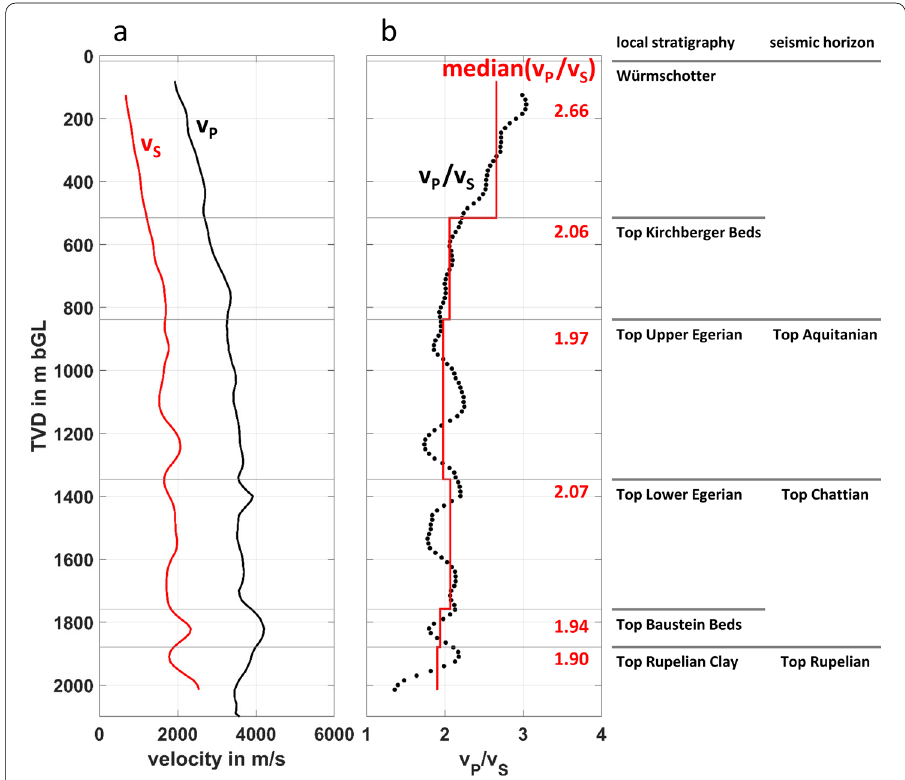
Fig. 5 Interval velocities and v p /v s ratio at Freiham TH-1. a v p (black line) and v s (red line) interval velocities, b the resulting v p /v s ratio (black dots) and median (red line). For each stratigraphic sequence, a single median was calculated (red